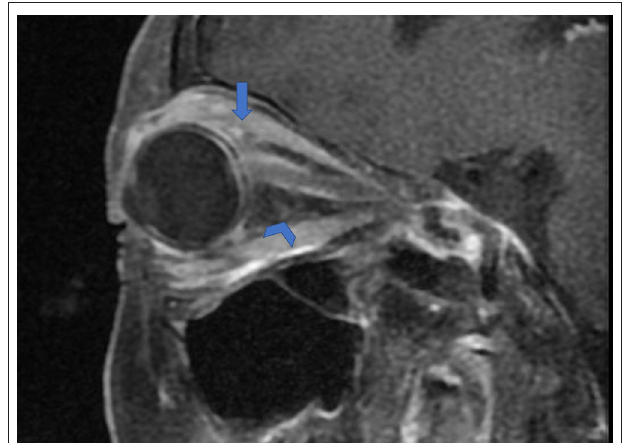
FIGURE 5 | Orbital fat inflammation and inflammatory cell infiltration in OPN. Sagittal contrast enhanced T1-weighted MRI showing orbit fat infiltration (arrowhead) and abnormal contrast enhancement on attachment point of the extraocular muscle (arrow).